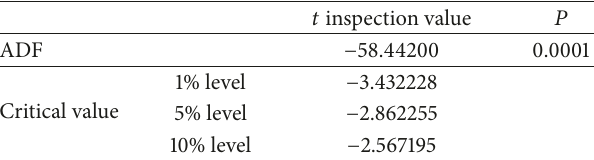
Table 2: ADF test of the logarithmic yield series of gold.